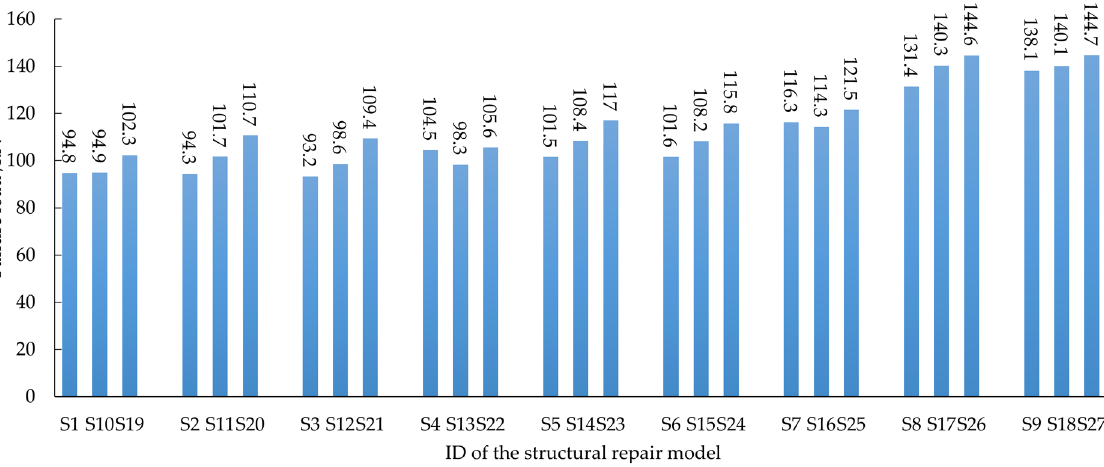
Figure 17. Failure loads of all structural repair models corresponding to nine groups with repair widths. repair